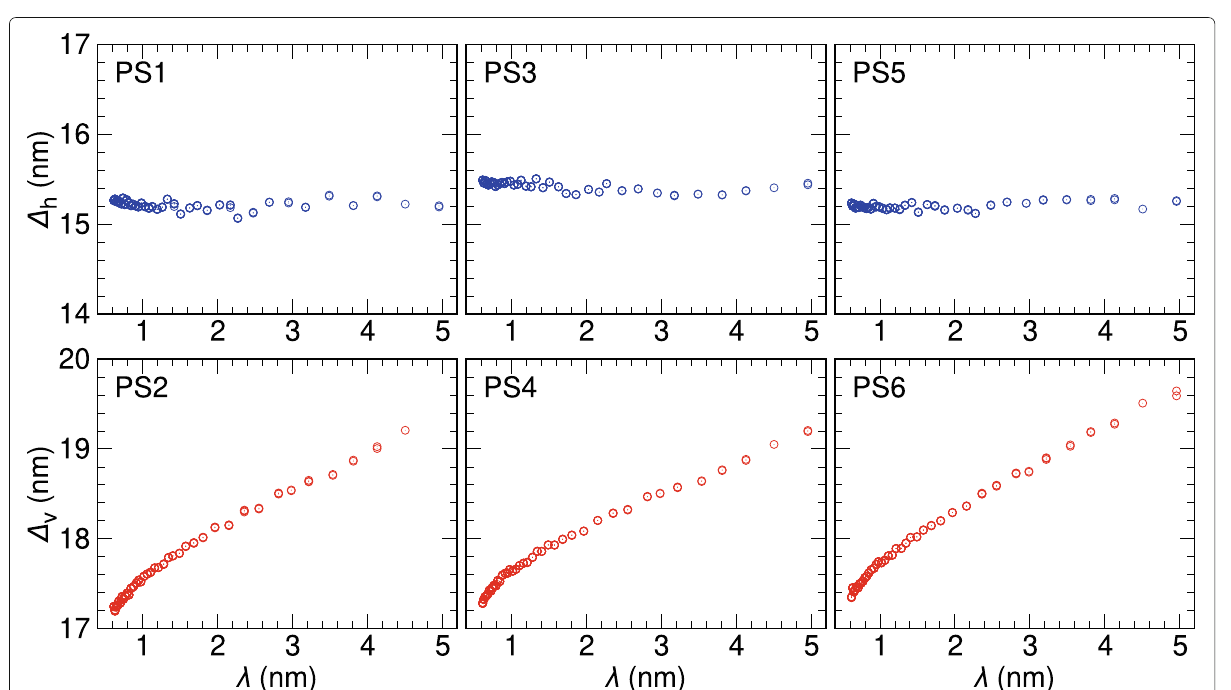
Fig. 14 (cid:10)(λ) in LH and LV modes. (cid:10) h,v (λ) was calculated from the optimized p ( g ) and the determined n h,v in (top) LH and (bottom) LV modes